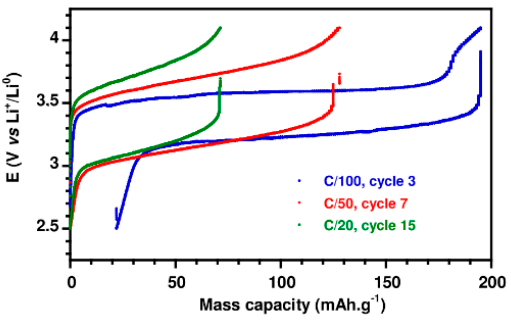
Figure 8. Cycling performances of Li|LiFePO 4 cell at different current densities (C/100, C/50 and C/20)